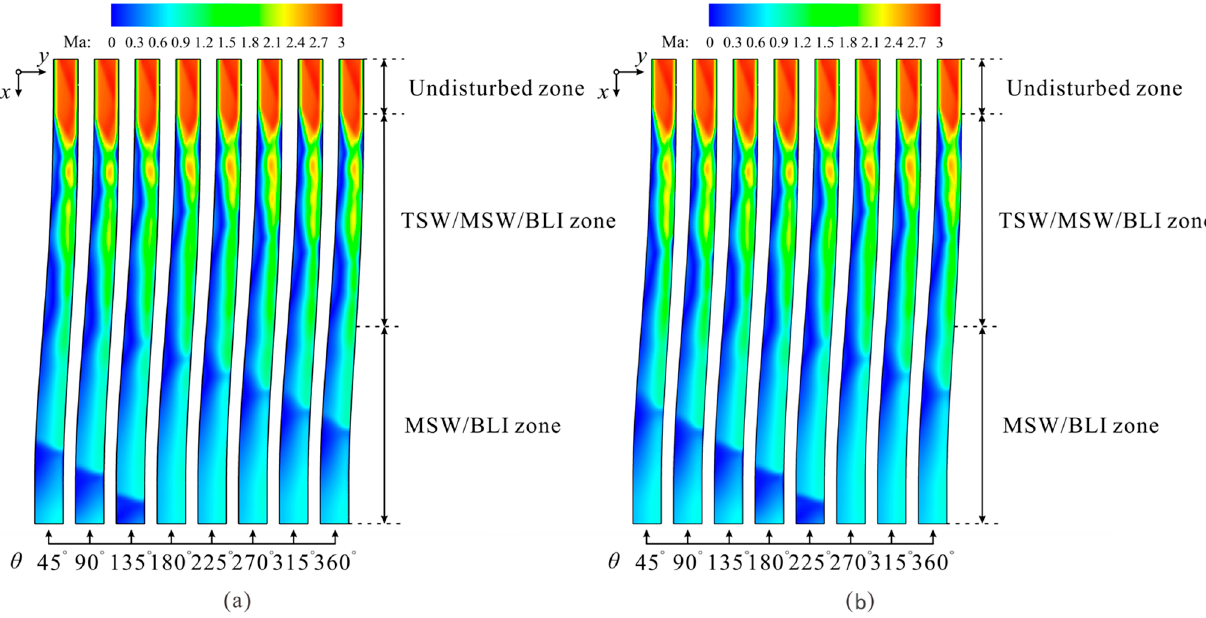
Figure 17. Mach number contours of eight meridian planes at different moments in one period. ( a ) t = n T . ( b ) t = (n + 1/4) T . ( c ) t = (n + 2/4) T . ( d ) t = (n + 3/4) T .